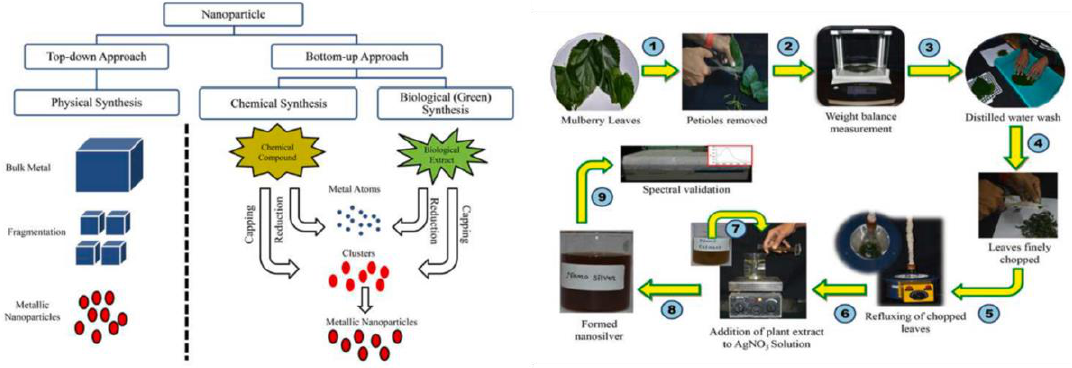
Figure 15. Schematic representation of ( left ) a top-down and bottom-up synthetic approach ( right ) of a phyto-synthetical Ag nanoparticles preparation. Reprinted (adapted) with permission from [121].